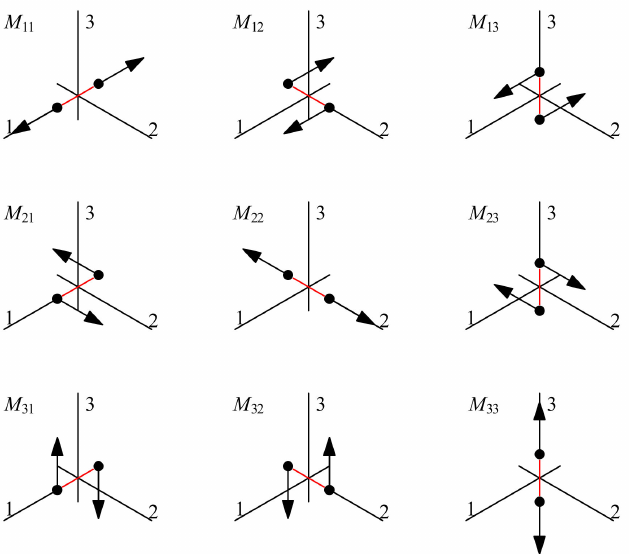
Figure 1. The nine different force couples that make up the moment tensor components. (After Shearer